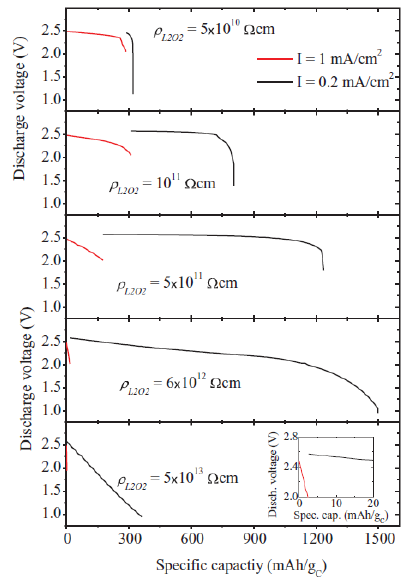
Figure 8. Discharge curves of Li-air cells computed for different lithium peroxide resistivities. Republished from Chen et al. [19] with permission of The Electrochemical Society, conveyed through Copyright Clearance Center, Inc.